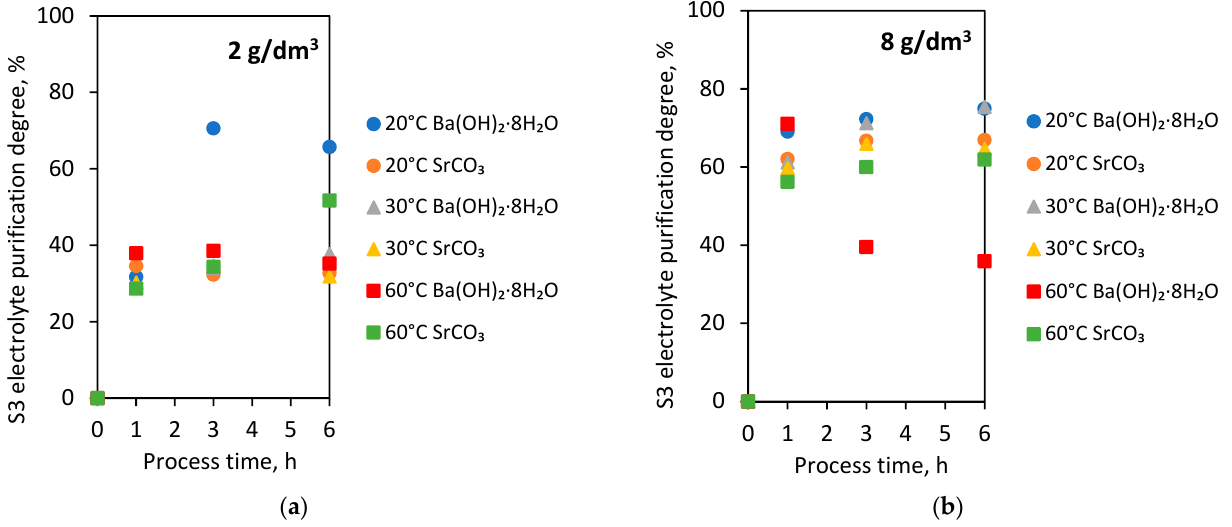
Figure 5. S3 electrolyte purification degree from process time and temperature with the addition of barium hydroxide octahydrate and strontium carbonate in the amounts ( a ) 2 g/dm 3 ; ( b ) 8 g/dm 3 . The electrolyte purification degrees were higher with the 8 g/dm 3 addition of both bar ‐